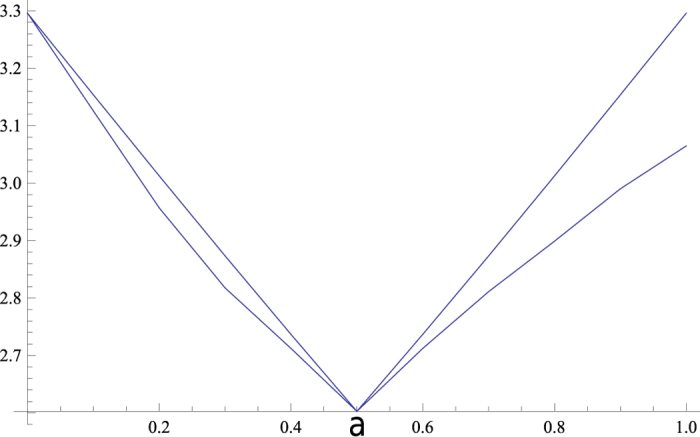
Comparison of our two bounds via combinatorial and majorization methods: the top curve is ropt (combinatorial), while the lower curve is rx (majorization).